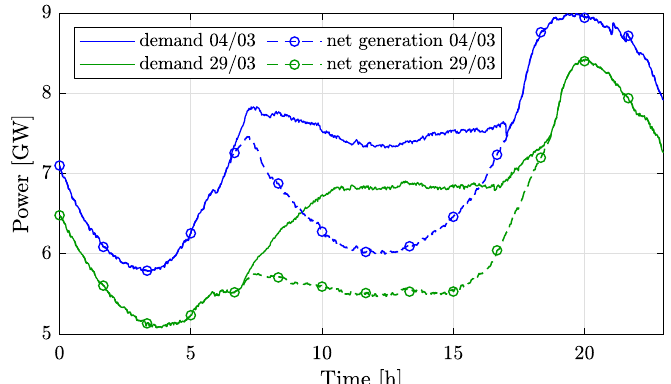
Figure 8. Comparison of the total demand and conventional generation in Israel during 24 h on two sunny days: 4 March and 29 March